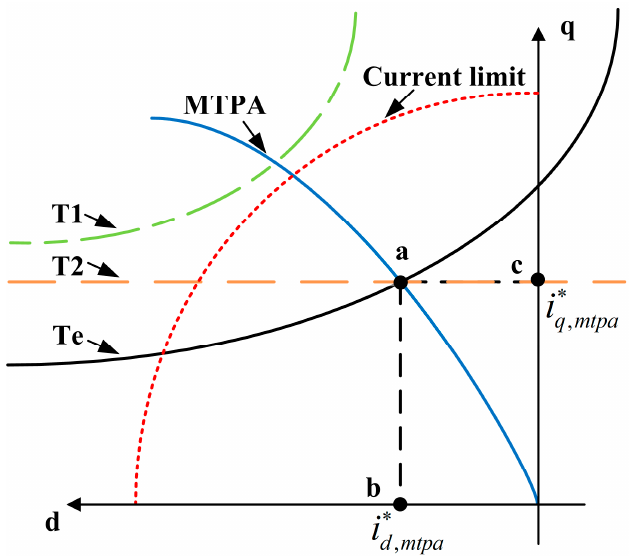
Figure 2. The relationship between the given torque and MTPA operating point.